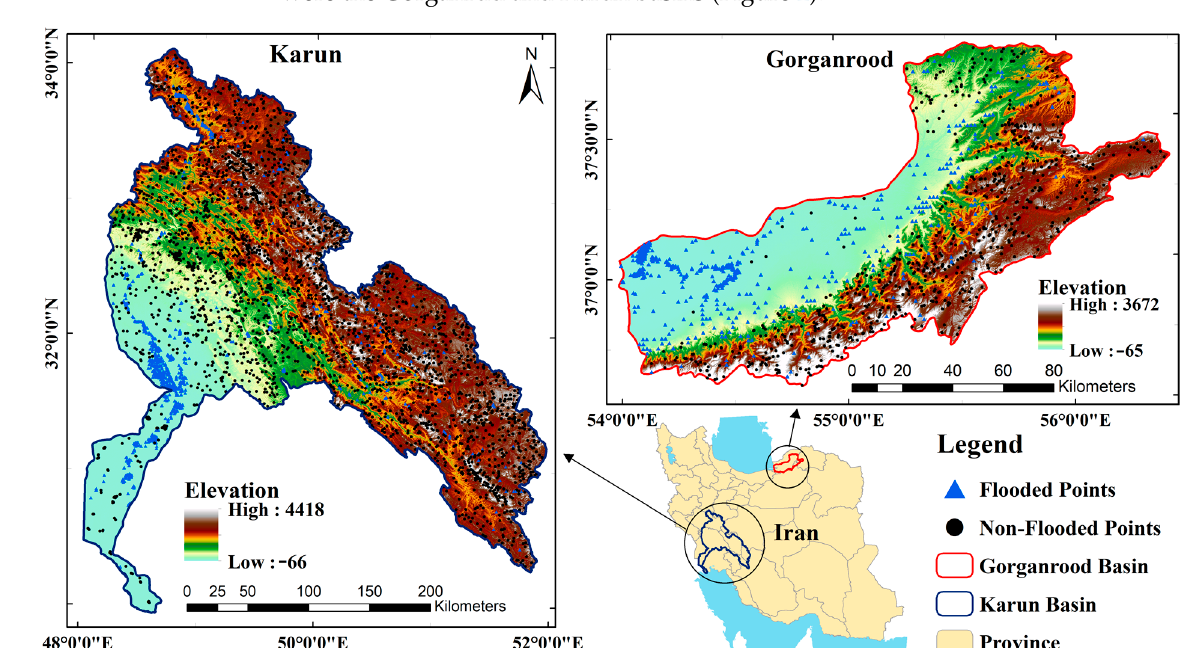
Figure 2. Location of the study areas and flood